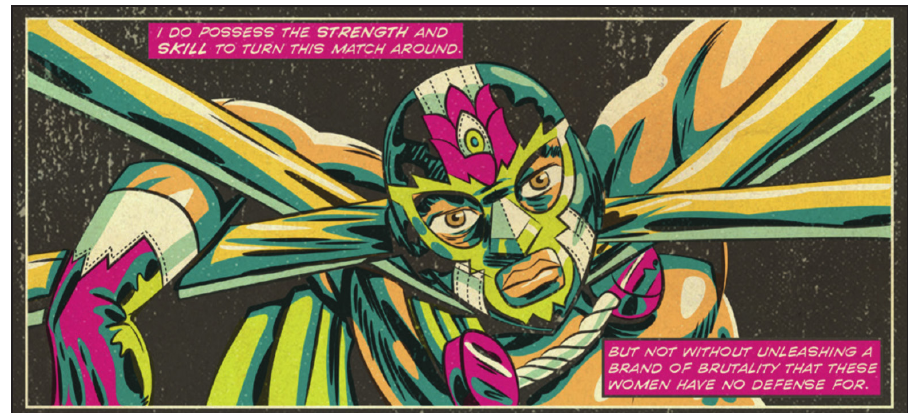
Figure 5 The protagonist defeated by three malicious luchadoras in J. Gonzo’s La Mano del Destino Collected Edition by Jason Gonzalez, 2021: 67. © 2021 J. Gonzo Designs,